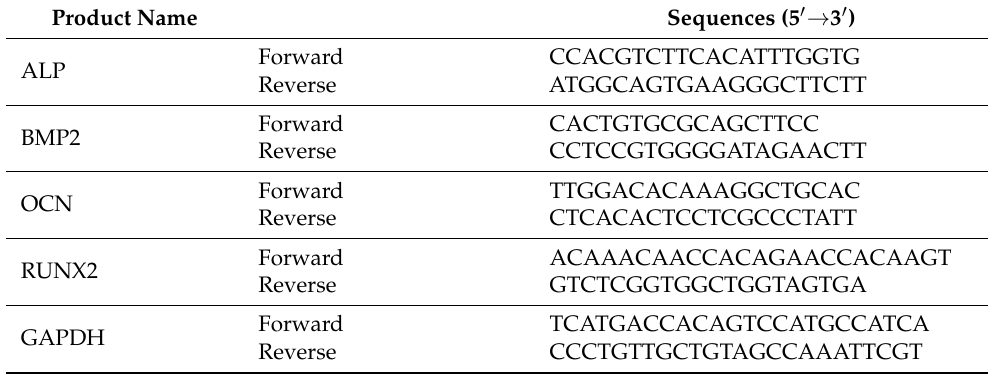
Table 1. Primers with corresponding sequences used in the study.